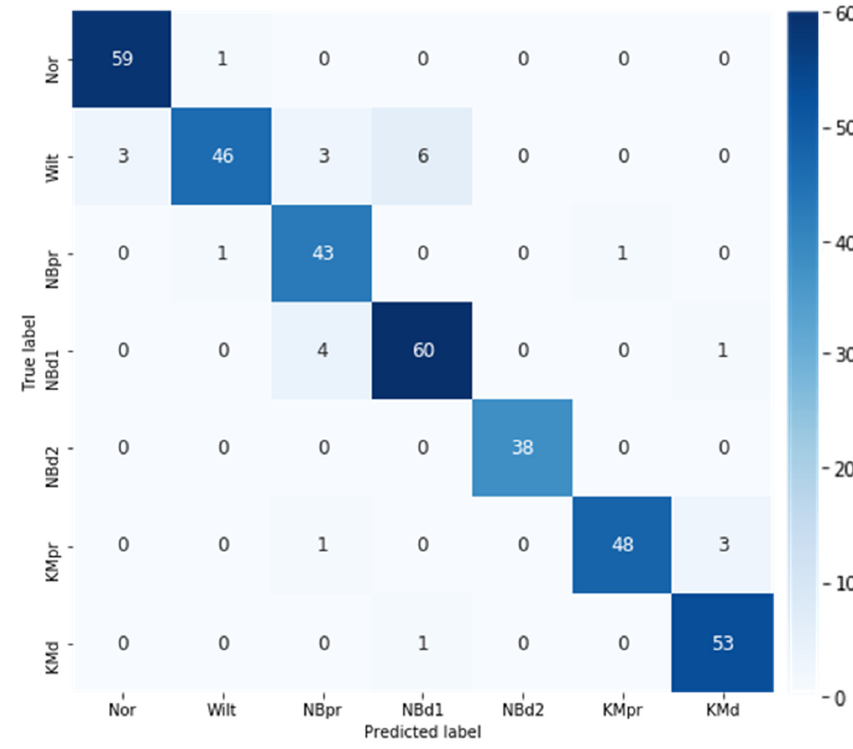
Figure 8. Test set confusion matrix for the Adagrad optimizer model.